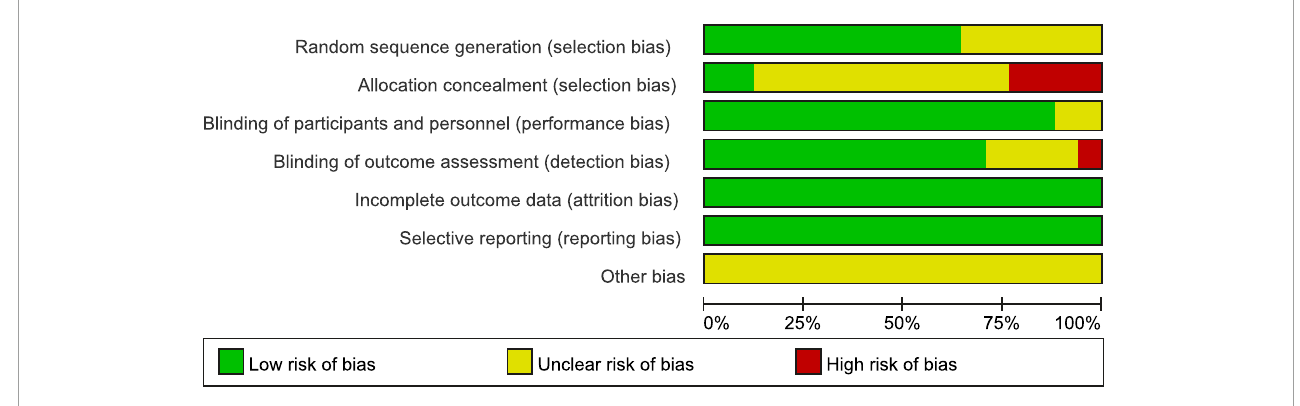
FIGURE3 Risk of bias graph according to the Cochrane risk of bias tool.